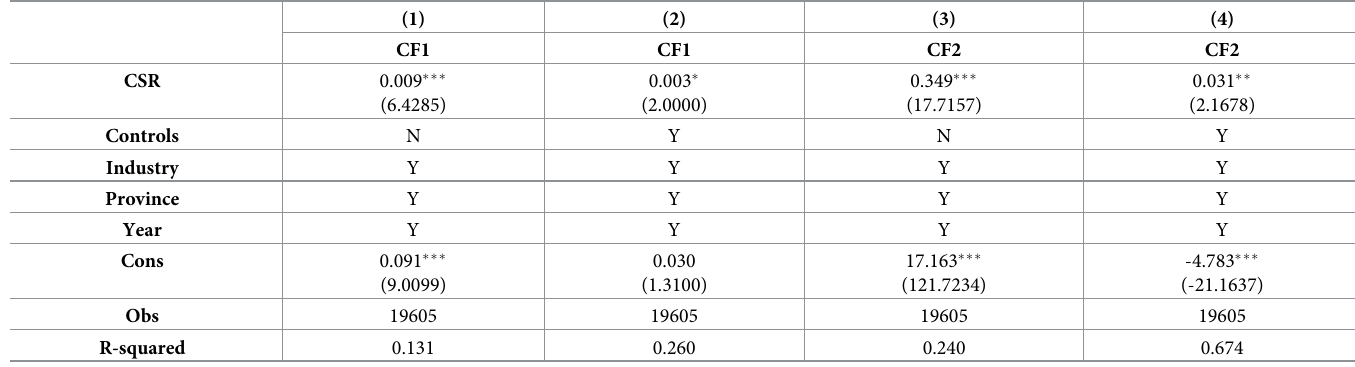
Table 10. Robustness test: lnCSR regression.